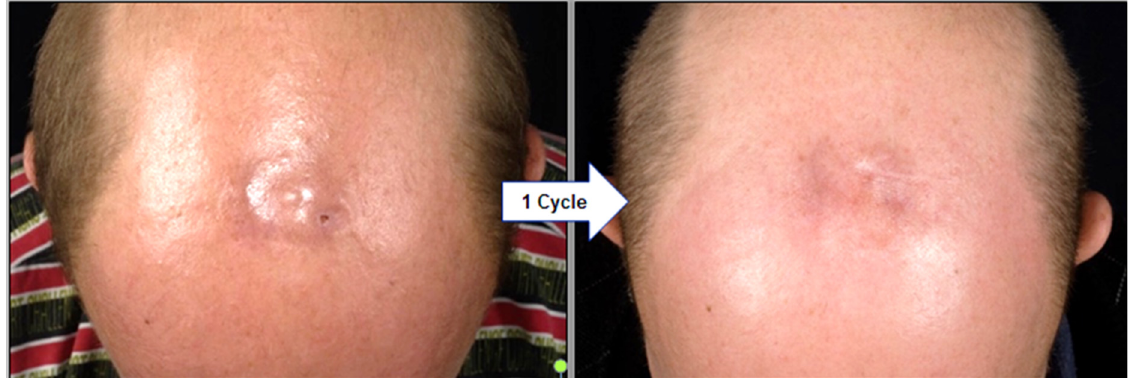
Figure 1. Clinical regression of PCFCL on the scalp in a 63-year-old patient three weeks after his first cycle of ILR. A median of one cycle (three injections) of ILR was required in our cohort to achieve complete remission (CR). PCFCL = primary cutaneous follicle center lymphoma; ILR = in- tralesional rituximab.